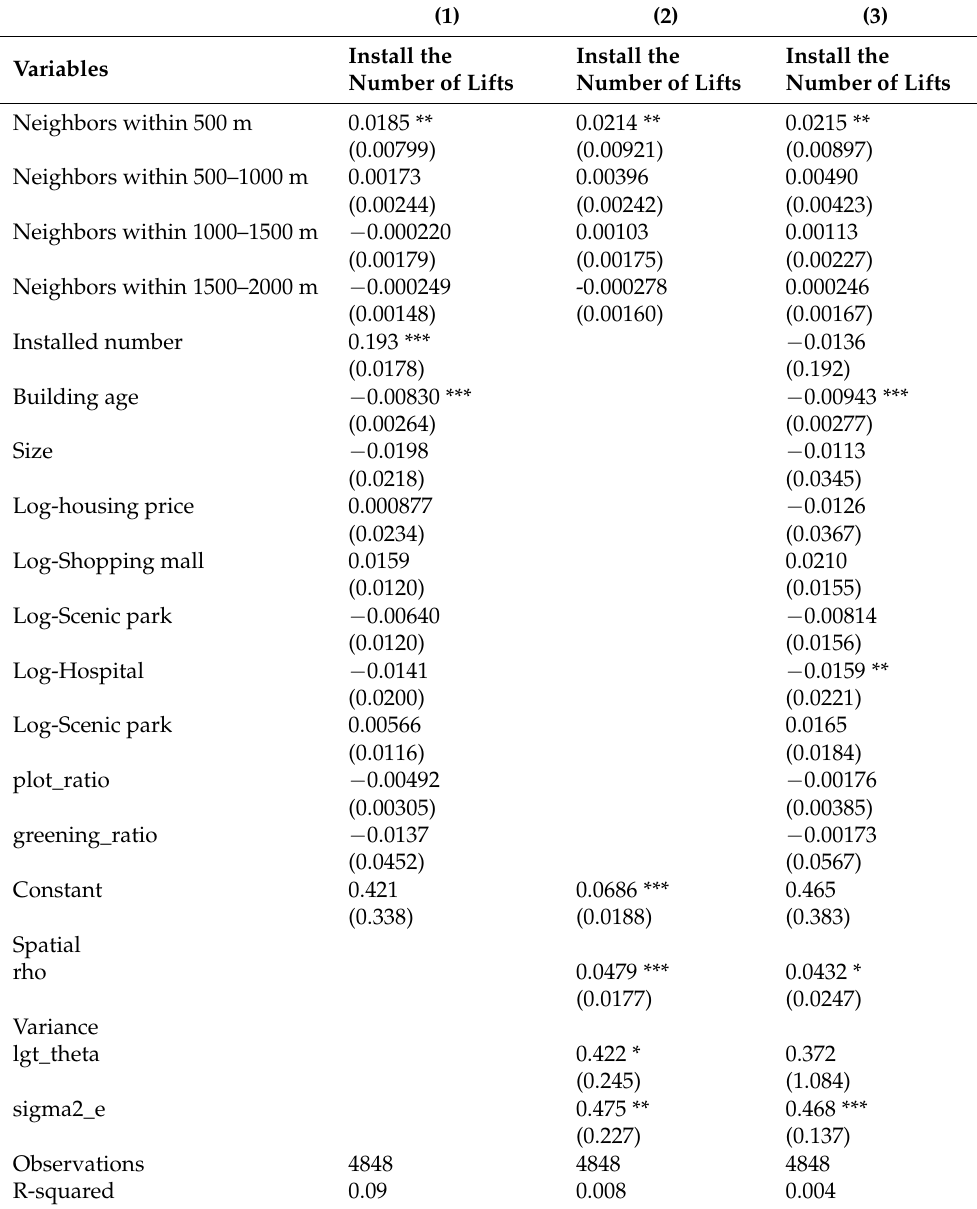
Table 3. Empirical